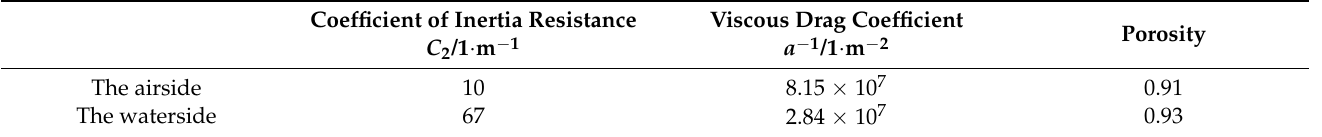
Figure 3. The curve of j / f factor with Reynolds number. Table 2. The porous medium of charge air